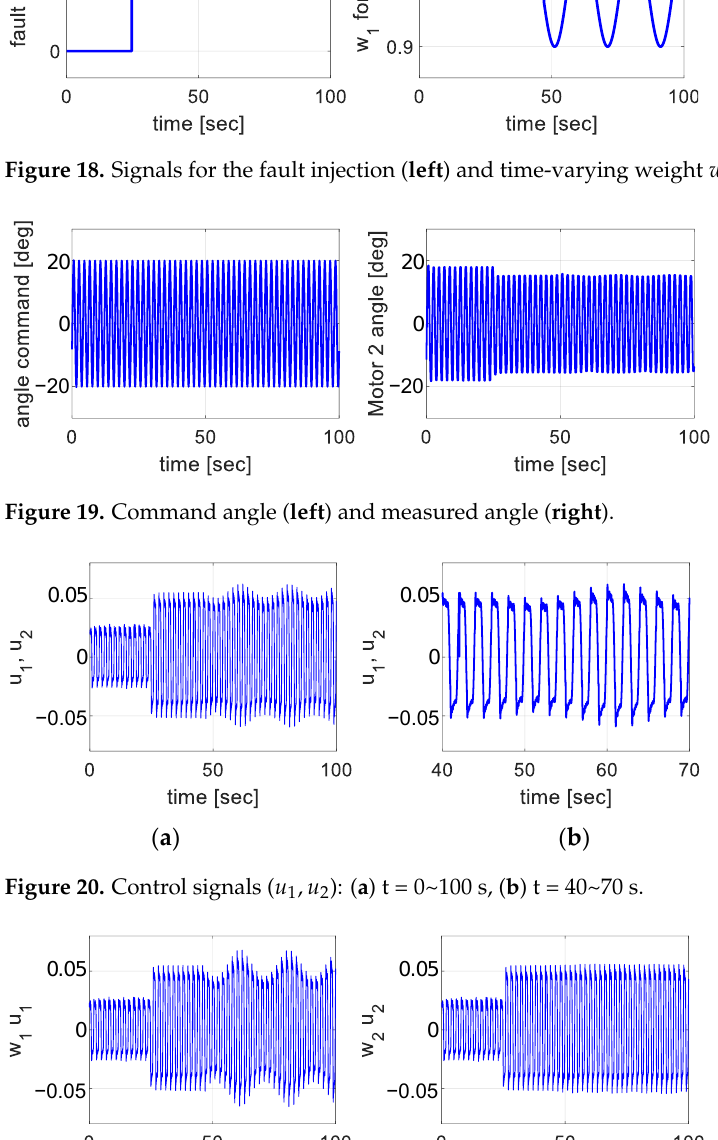
Figure 21. Modulated control signals: (left) 𝑤 1 𝑢 1 , (right) 𝑤 2 𝑢 2 .